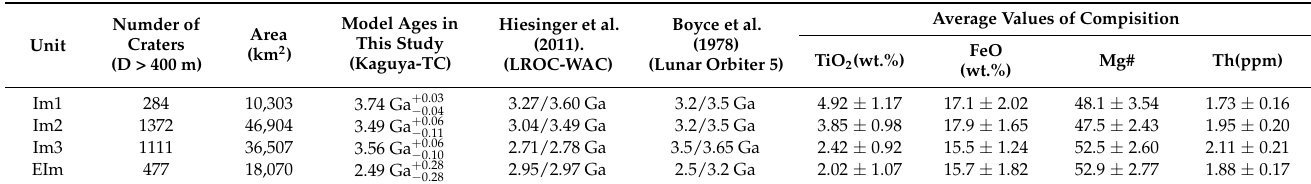
Table 1. The mare units in the Crisium